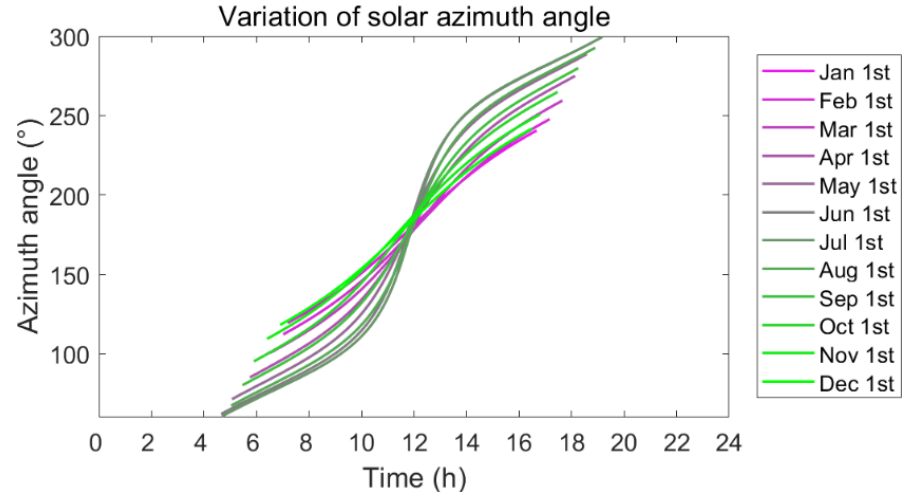
Figure 4. Variation of the solar altitude angle on the first day of each month in 2019. The horizontal coordinates indicate the time of day in hours; the vertical coordinates indicate the solar collector tilt angle in degrees; the different curves indicate the first day of the different months. The location is 37° N and 122° E.